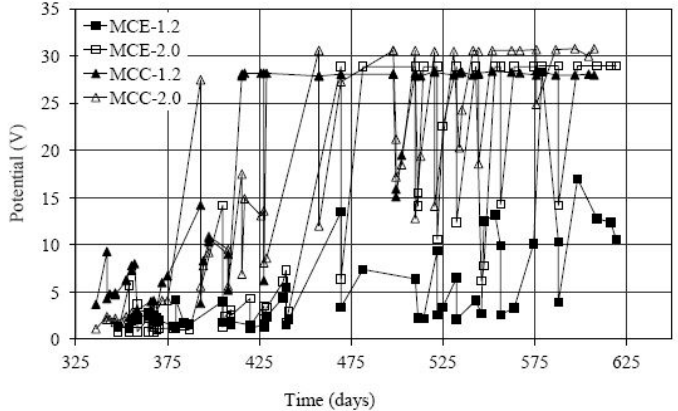
Figure 5. Evolution of the potential (V) necessary to maintain a constant current of 1.3 mA in each rebar.